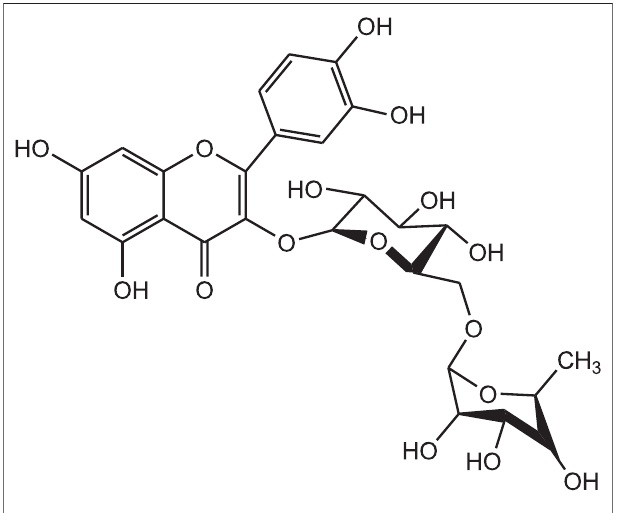
FIGURE 9 | Chemical structure of Rutin (Docking score: 9.16 kcal/mol).